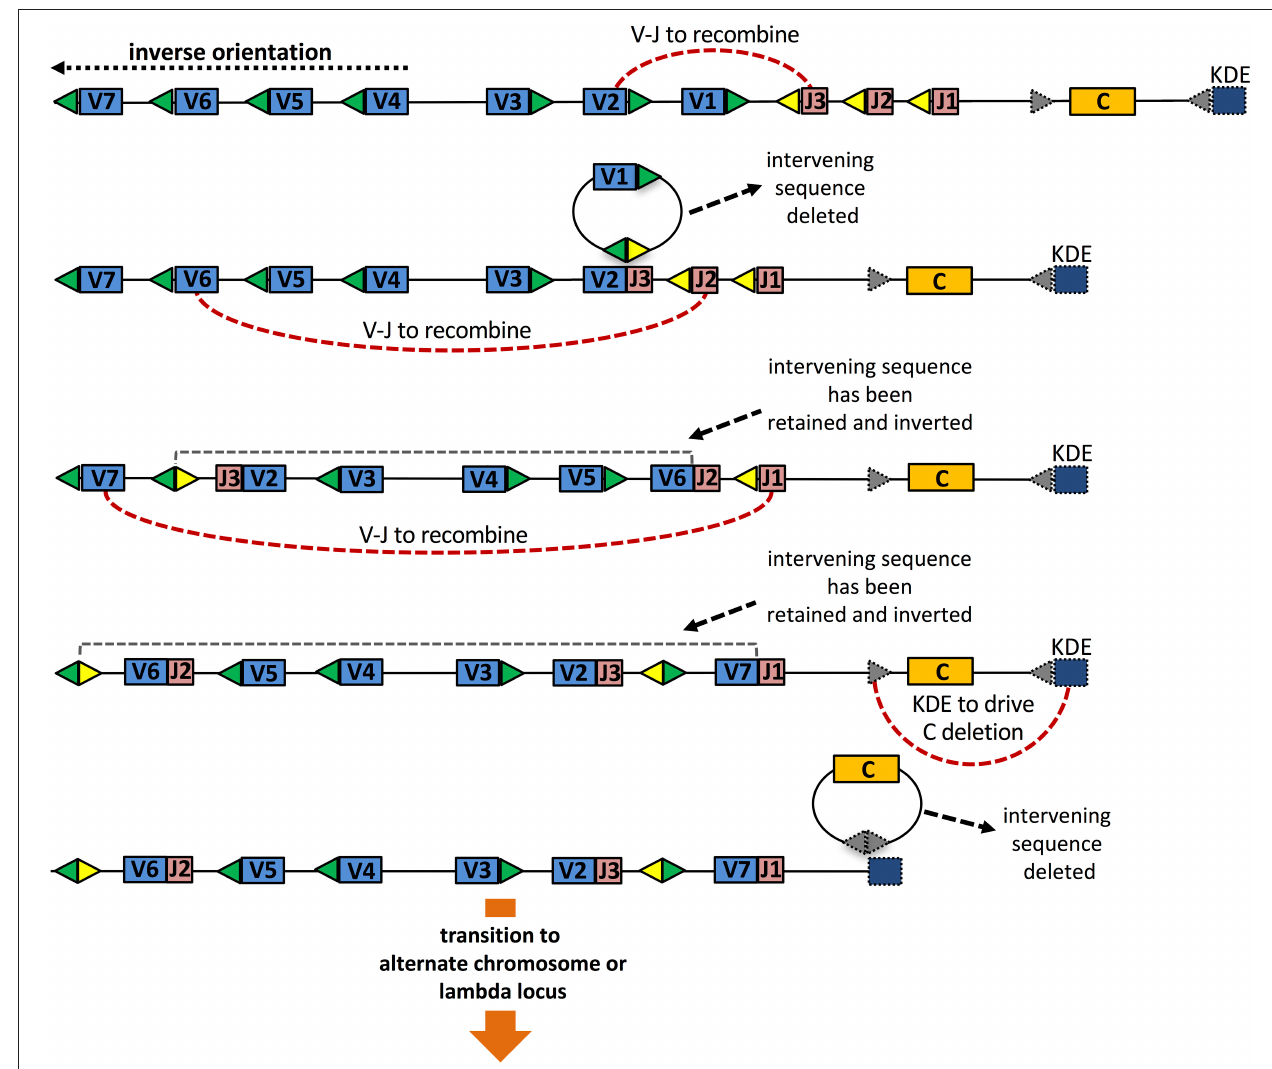
FIGURE 2 | Three rounds of VJ rearrangement of the κ locus, that might result from non-productive rearrangements or rearrangements resulting in self-reactive BCR. The initial configuration of genes (top) shows four IGKV genes in the reverse orientation to the IGKJ and IGKC genes, and 3 IGKV genes in the orientation shared with those genes. Gene loss, as well as the changing order and orientation of genes is highlighted through successive rounds of rearrangement. Expression of the final configuration (shown in row 4), which threatens allelic inclusion and possible continuing auto-reactivity, is terminated through the action of the Kappa Deleting Element (bottom)